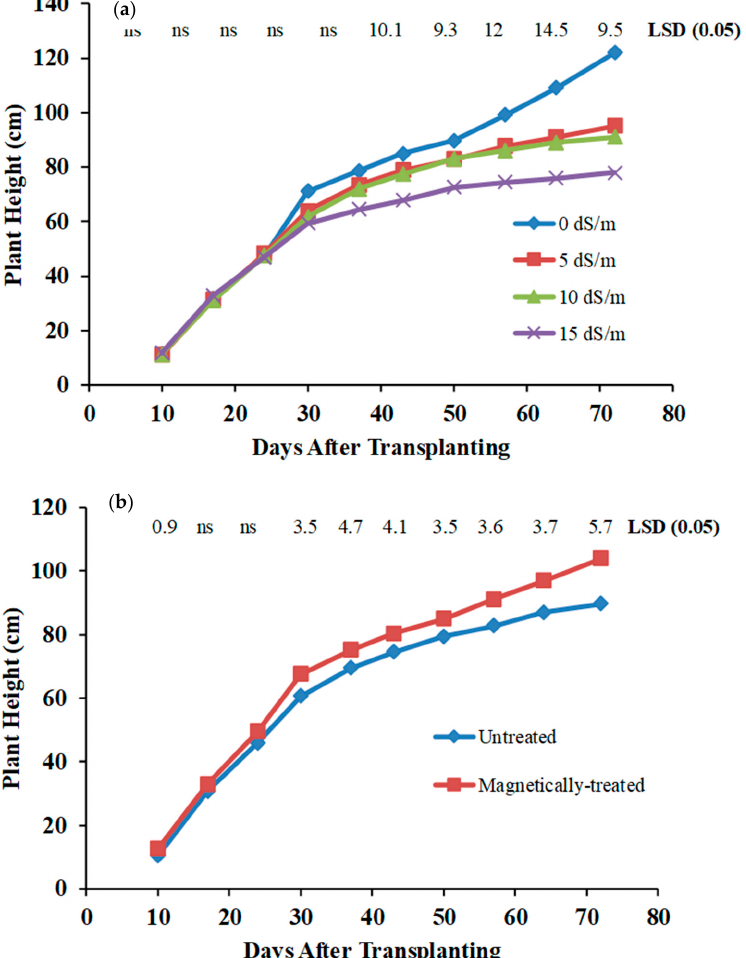
Figure 1. Plant height at different days after transplanting for tomato grown under four levels of salinity ( a ) and for plants grown under magnetically-treated and untreated water ( b ). Numbers at the top of the figures represent the LSD value at p < 0.05. Significant increases in plant stem diameter resulted when irrigating plants with magnetically-treated water (6.9 mm) compared to control plants (5.6 mm) (Table 3). As the salinity level of the irrigation water increased, plant stem diameter at the end of the growing season significantly decreased. The greatest plant stem diameter (8.3 mm) was recorded for the plants irrigated with distilled water (0 dS/m), while the lowest plant stem diameter (4.3 mm) was recorded for the plants irrigated with the highest saline water (15 dS/m) (Table 3).